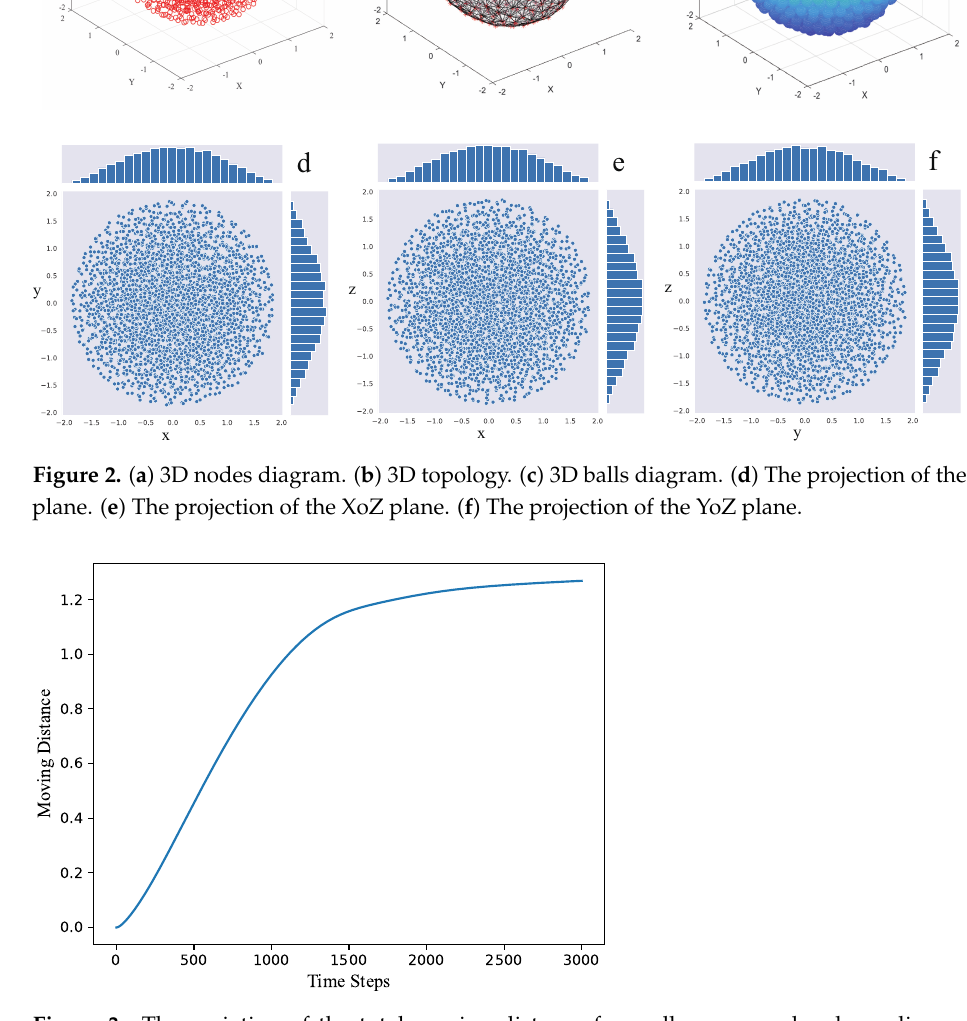
Figure 3. The variation of the total moving distance from all sensor nodes depending on the calculation time